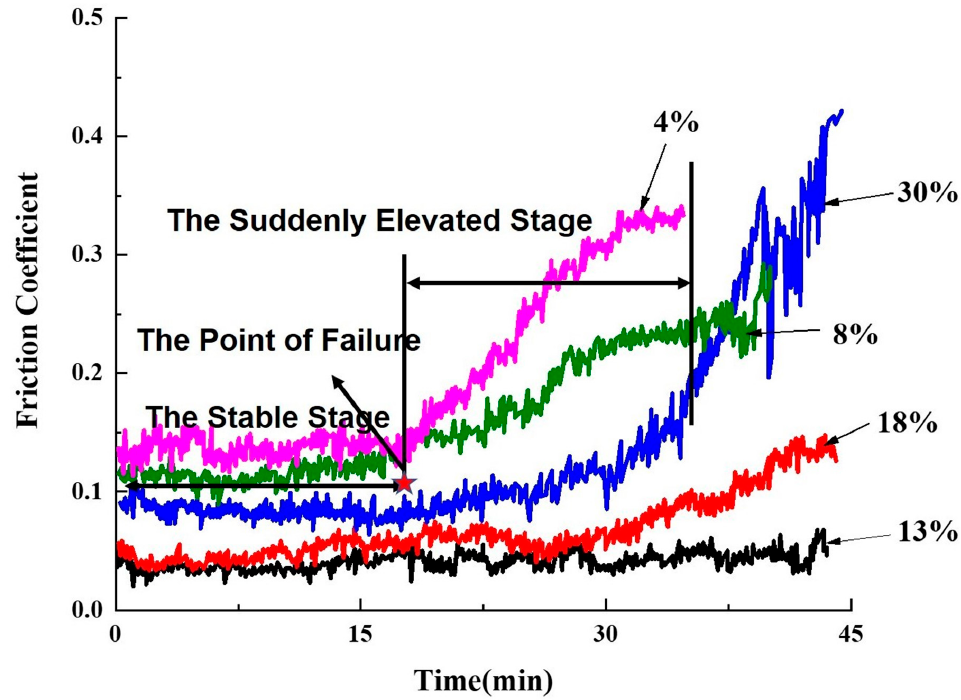
Figure 7. The friction coe ffi cient curves of the biomimetic